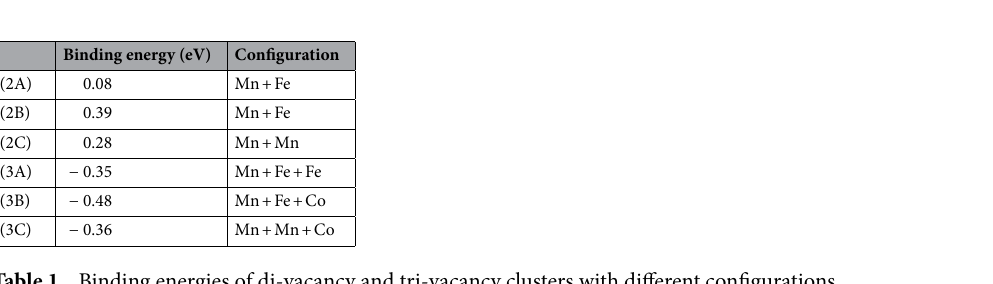
Table 1. Binding energies of di-vacancy and tri-vacancy clusters with different